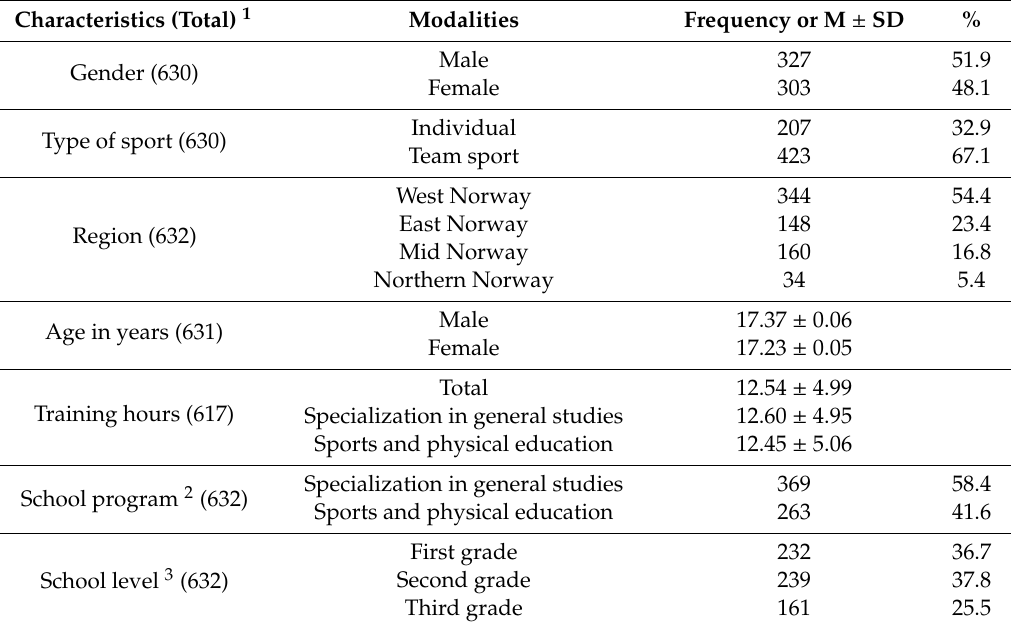
Table 1. The profile of the 632 student-athletes in the present